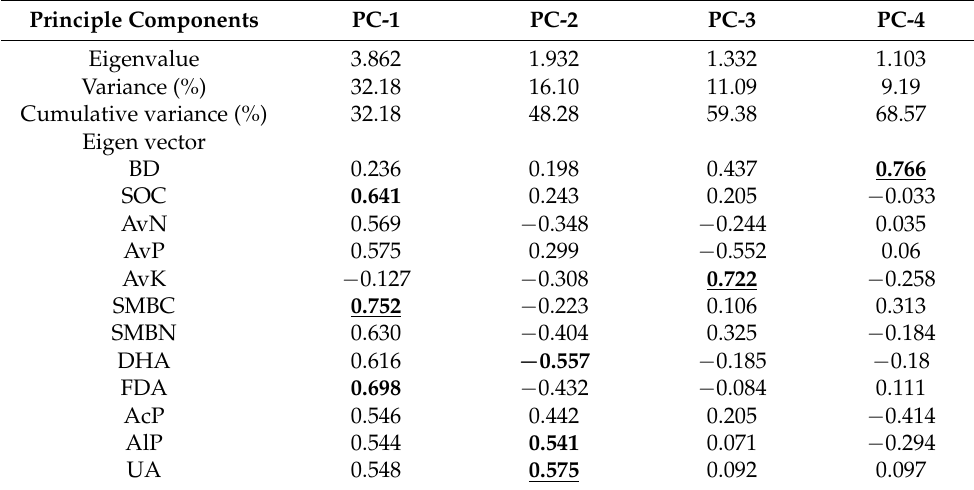
Table 5. Principle component analysis of the soil